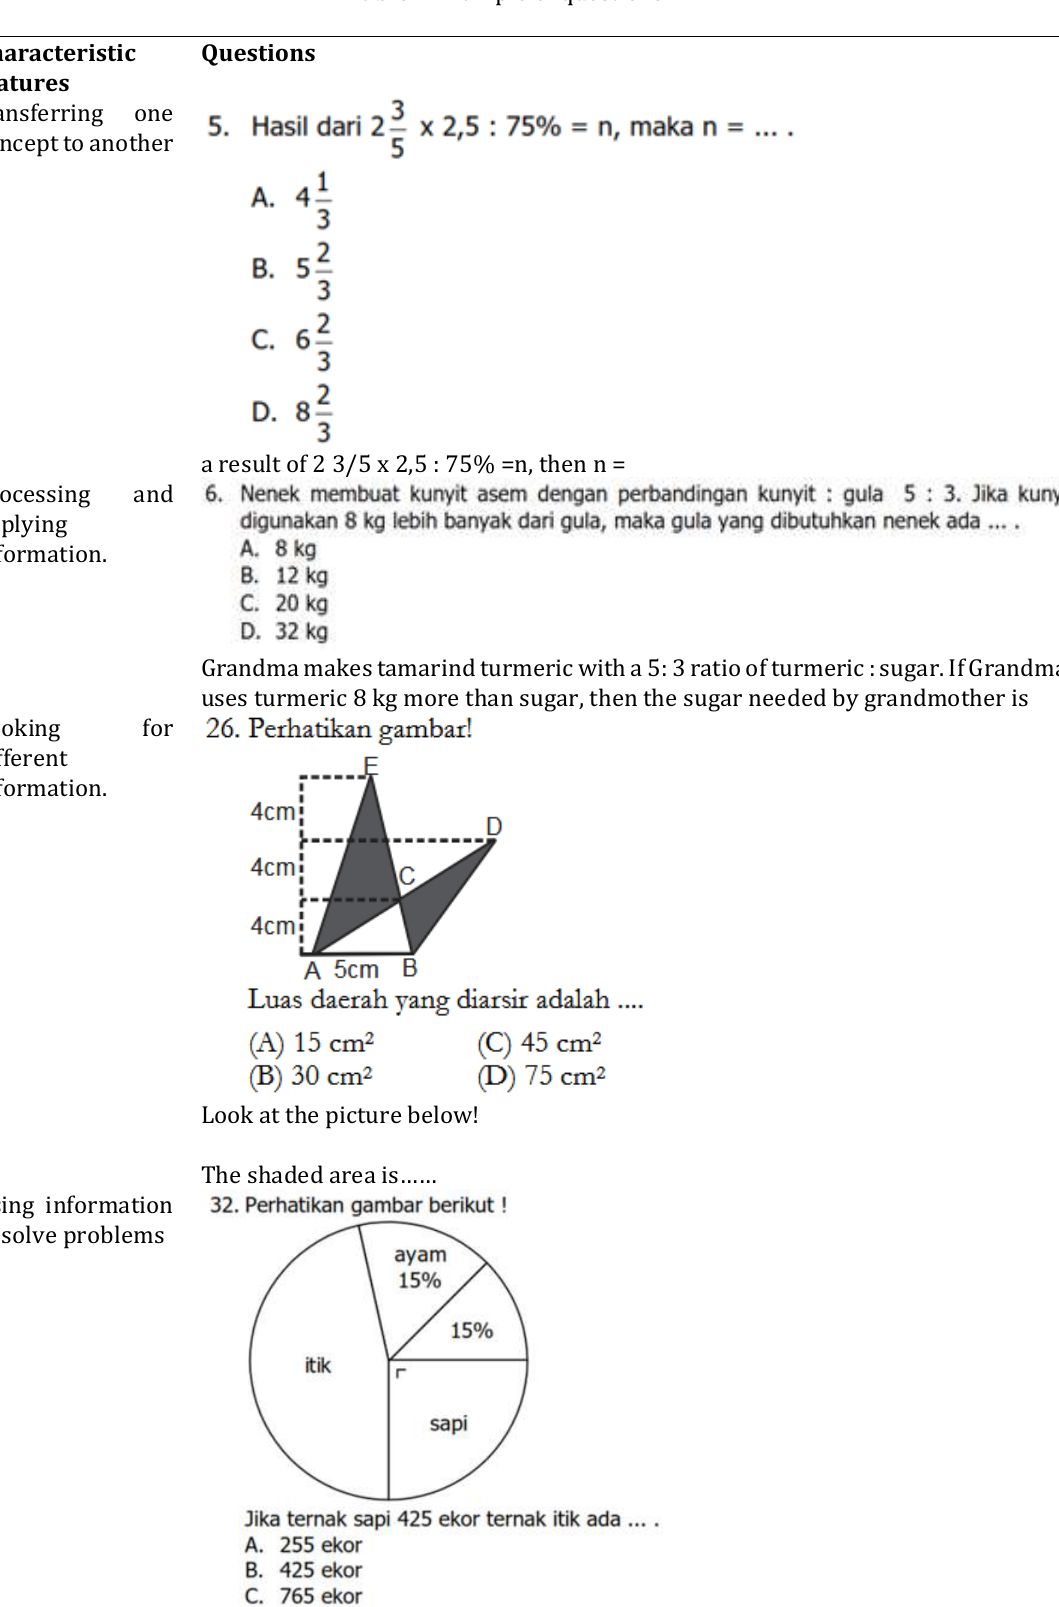
Table 2 Example of